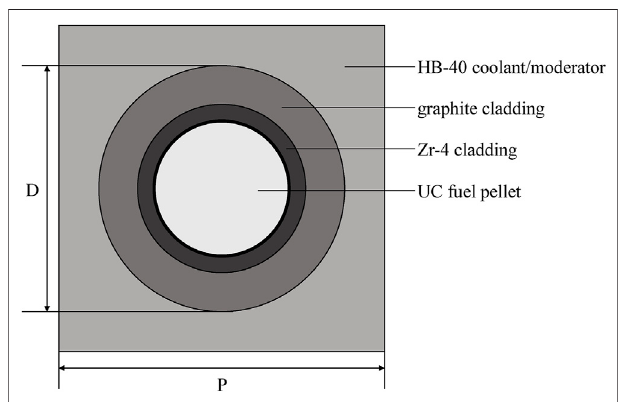
FIGURE 1 | Schematic diagram of the optimized fuel element.